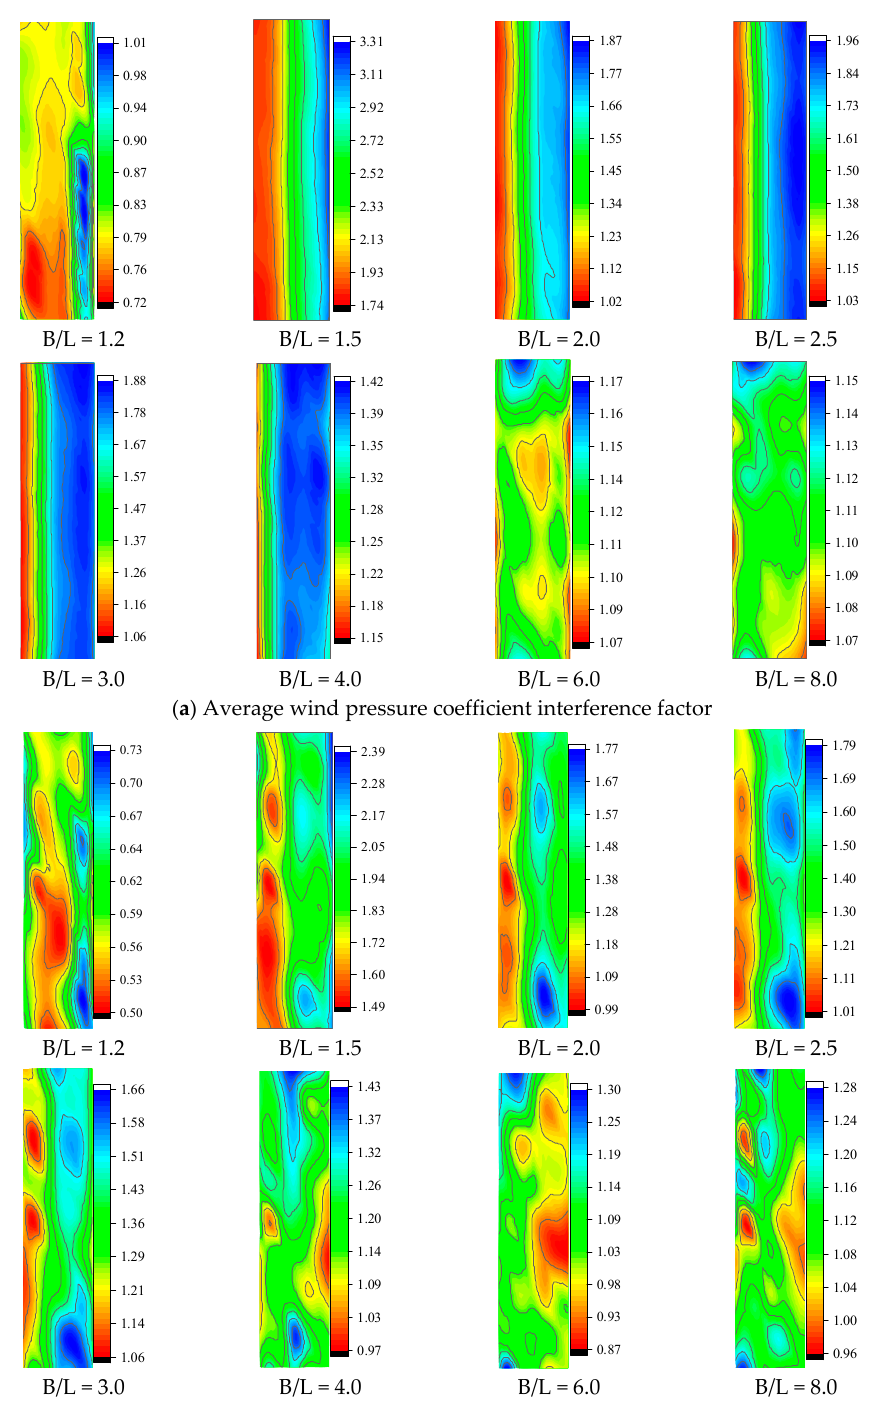
Figure 11. IF contours of the north facade.